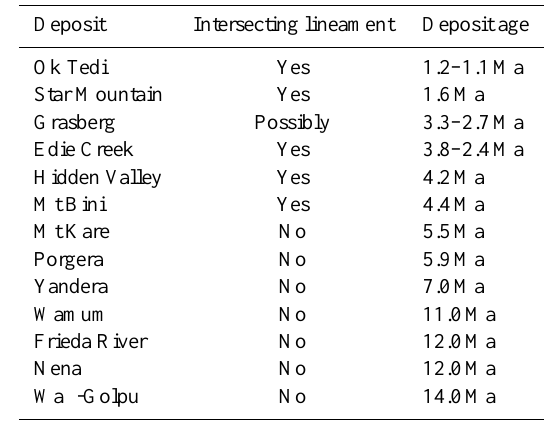
Table 2. List of Cu-Au, Cu-Mo, Au and Au-Ag deposits in New Guinea, their age and whether a NNE-trending structure that was identifiable in gravity and magnetic data dissects the region of the deposit. The deposit ages were taken from Garwin et al.